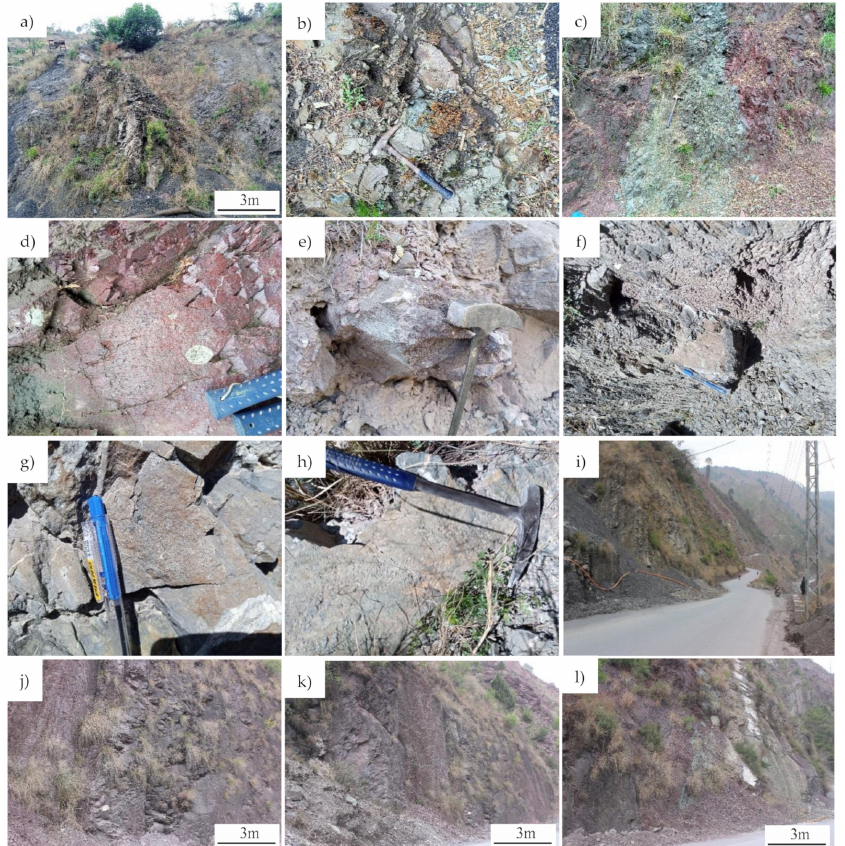
Figure 3. Photomicrograph showing ( a ) mudstone, ( b , l ) pencil-like shales, ( c ) variegated color shale, ( d ) reduction sports, ( e ) fine and coarse grain sandstone, ( f , g ) lenses of limestone, ( h ) coarse-grained sandstone, ( i ) lower contact of Kuldana Formation, ( j ) cyclic deposition of shales and sandstone, ( k ) sandstone lens in shales, ( l ) variegated colored pencil-like shales and limestone bed.